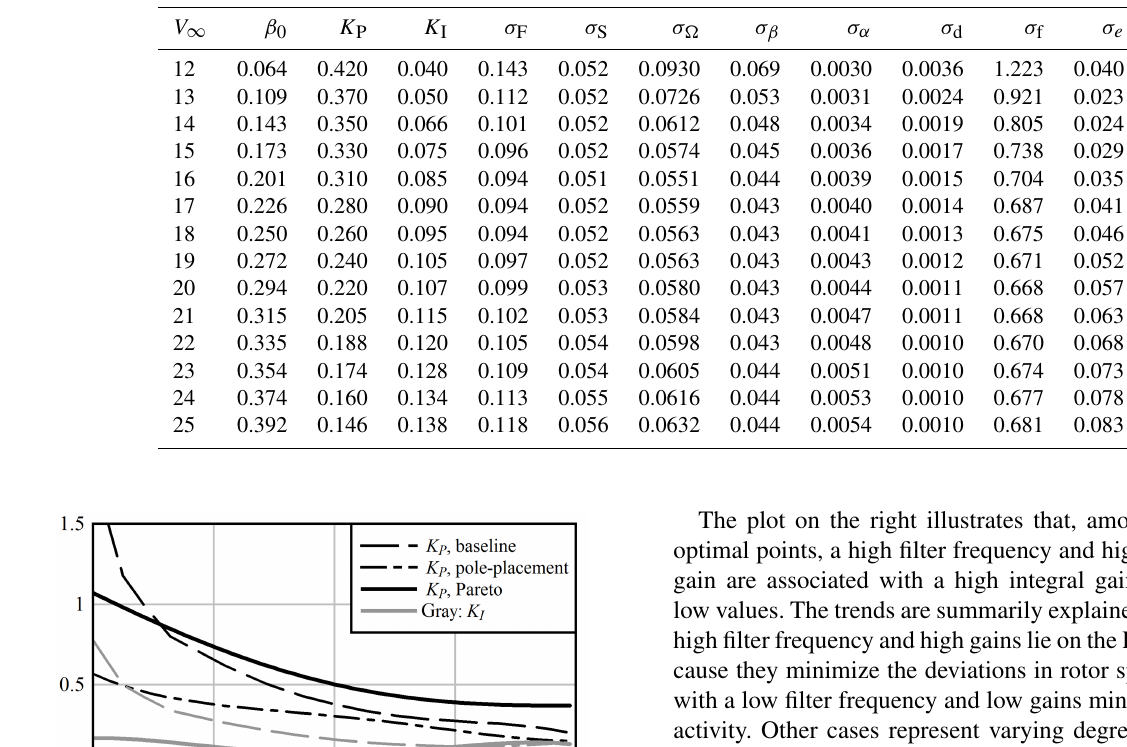
Table 3. The pole-placement tuning and resulting metrics. The low-pass filter frequency f L is 0.20Hz in all cases. For abbreviations, please see the table in Appendix A.